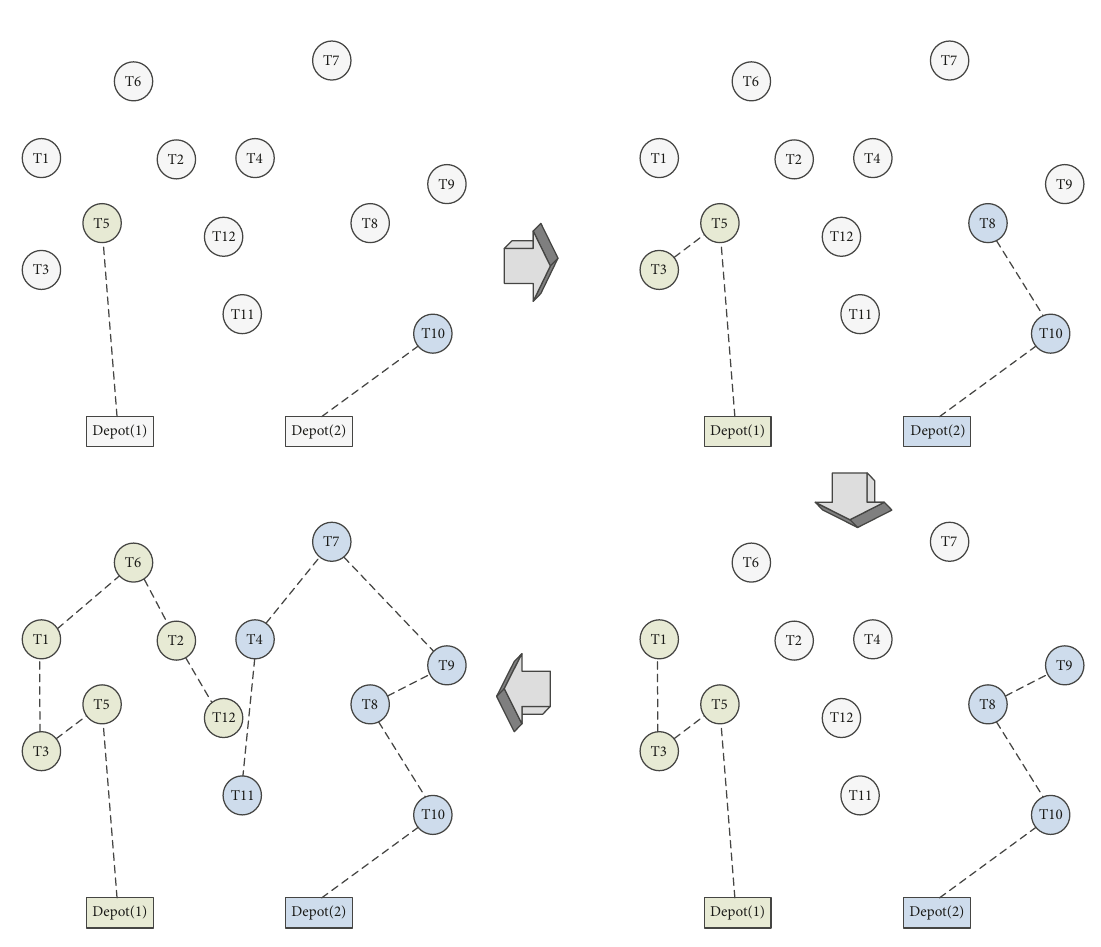
Figure 2: The operation process for the GSC